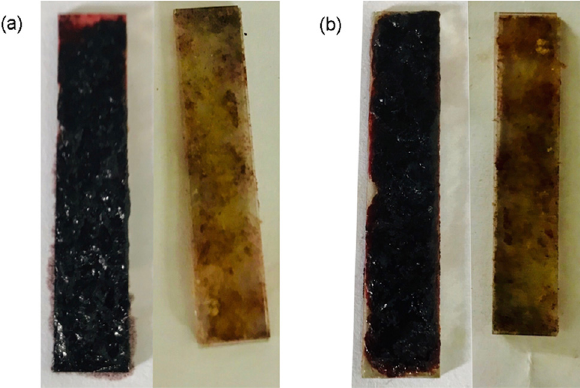
Figure 2: Digital picture of polymer fi lms immersion in AN: ( a ) P ( TTF - Th ) and ( b ) P ( DTTF - Th )